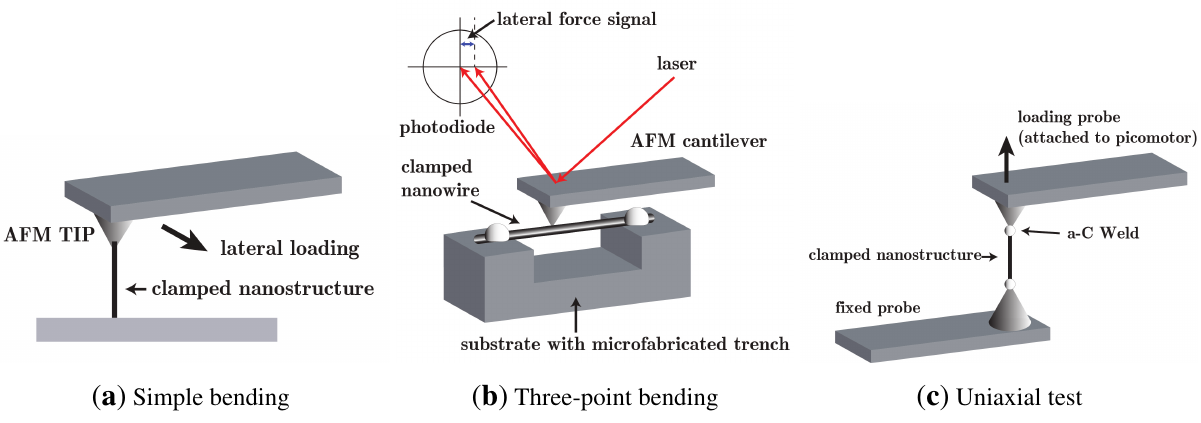
Figure 1. Three experimental configurations used to load nanostructures with an AFM cantilever: (a) simple bending by loading it laterally along the span through an AFM probe driven in lateral force mode; (b) specimen in fixed-fixed conditions subject to three-point bending (either laying flat on a substrate and loaded by the AFM tip laterally, or suspended over a known trench and loaded normally by an AFM tip in contact force